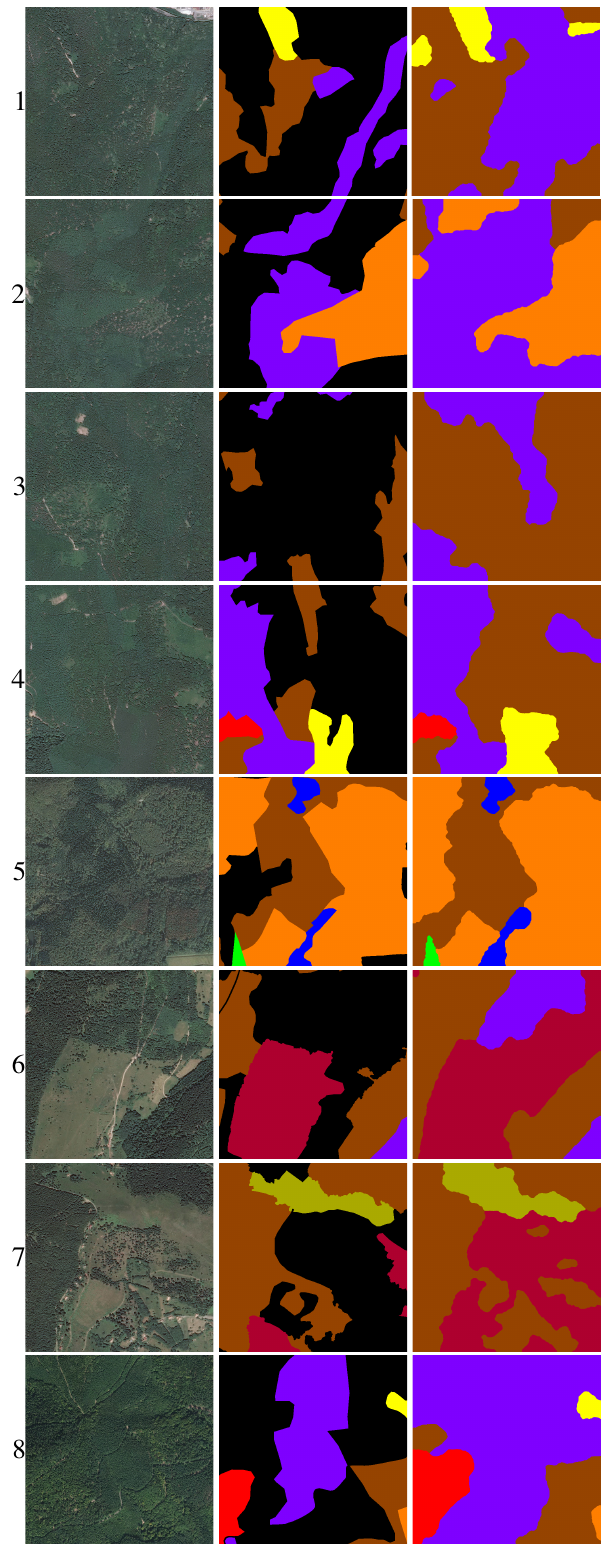
Figure 13. Results of the method for 8 areas of 1 km 2 . The first column contains the orthoimage of the areas, the second contains the polygons delineated by photo-interpreters (black color cor- responds to unlabelled data) and the third column contains the result of the regularisation. See Figure 5 for the colour